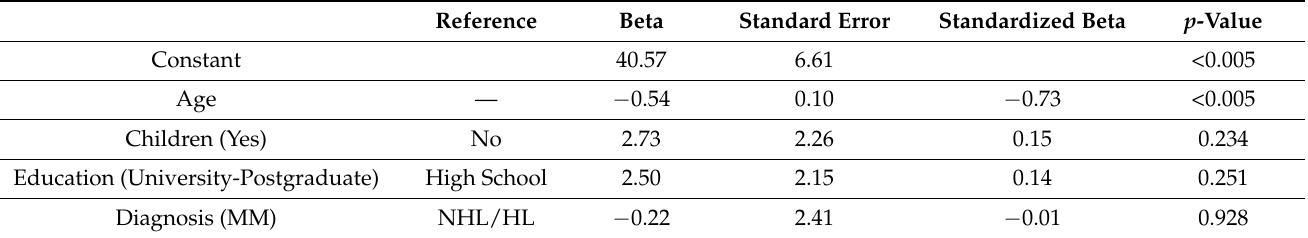
Table 4. Multifactorial analysis of survivors’ total FSFI score with demographic and clinical